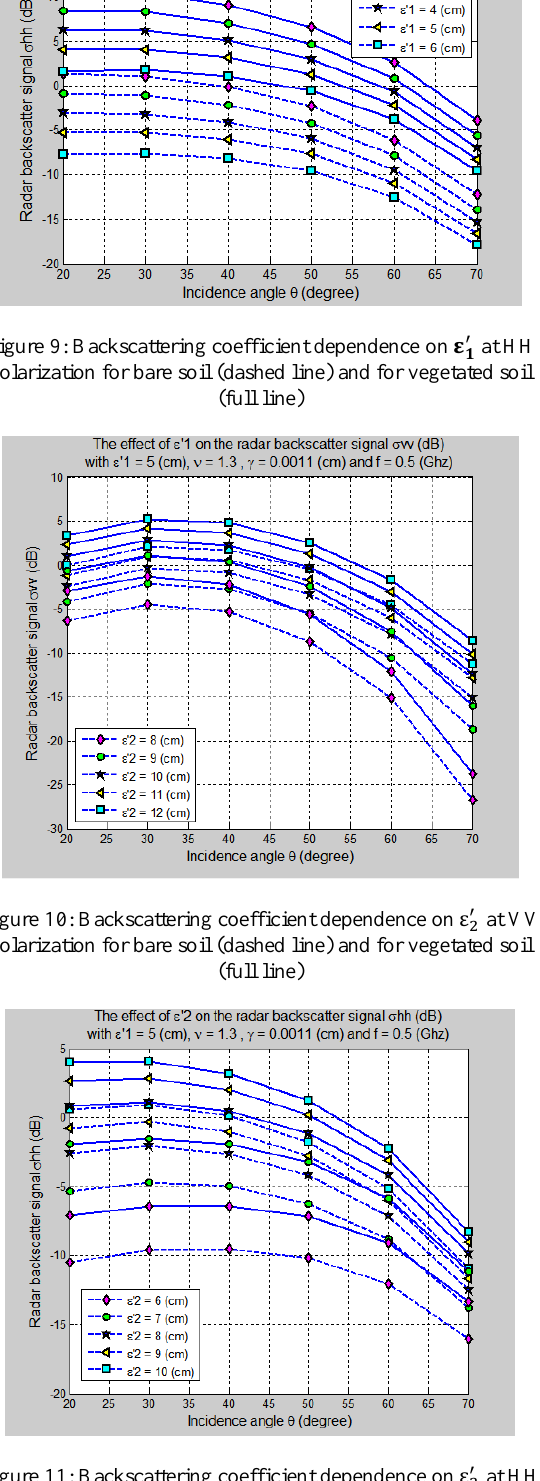
Retrieval Values (with impact of